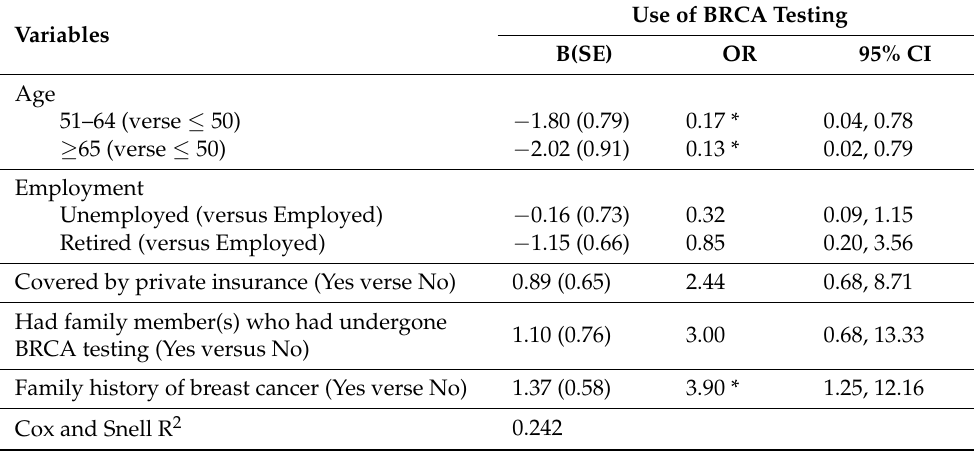
Table 2. Binary logistic regression results of the use of BRCA